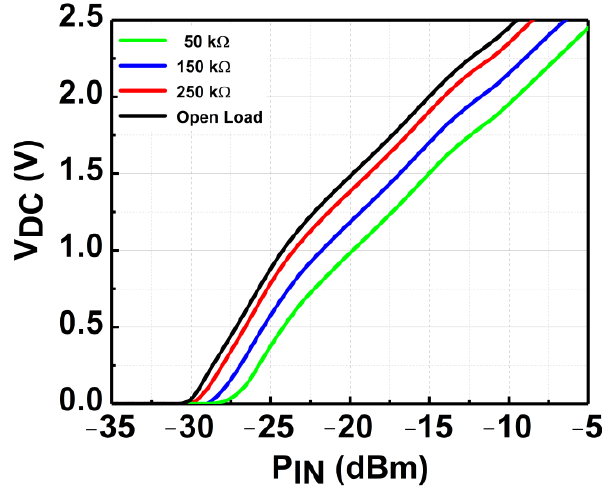
Figure 19. Measured V DC of the CCDD-TVB rectifier at 3 GHz for different load conditions.